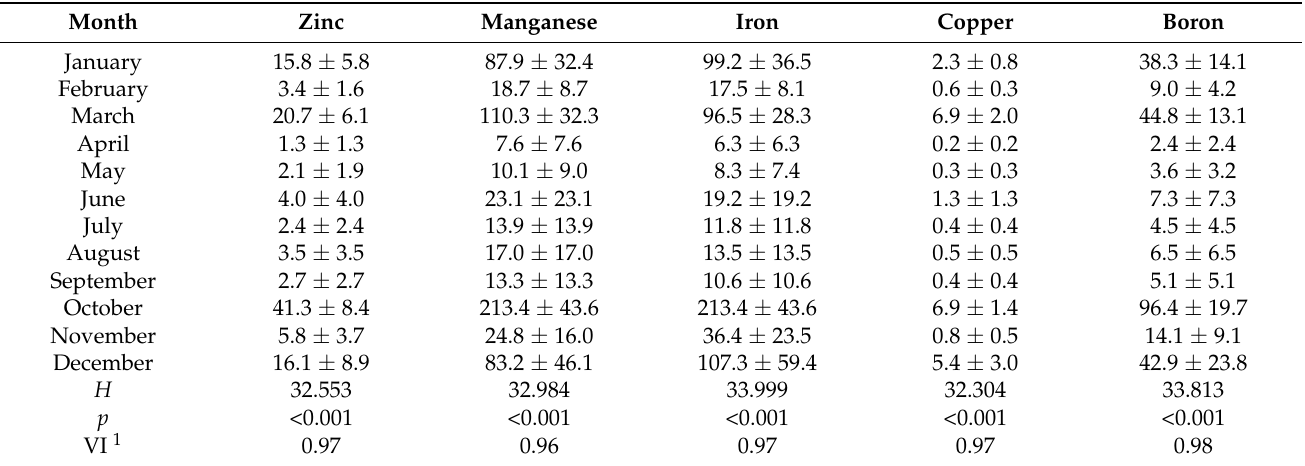
Table 4. The influence of month of year on micronutrient return ( µ g · m − 2 ) in Serianthes nelsonii fruit